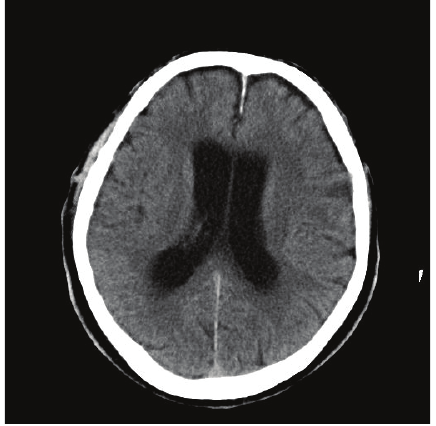
Figure 2: CT of the brain without intravenous contrast on the fifth day of admission showing development of a communicating